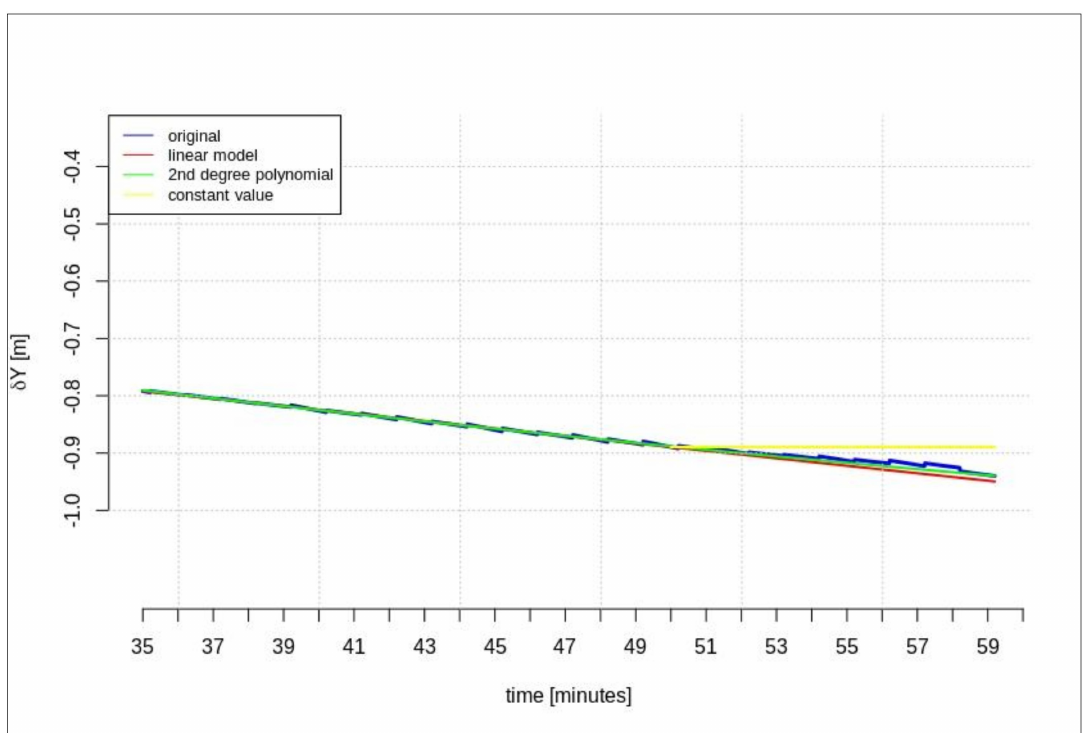
Figure 15. The results of the δ Y geocentric correction extrapolation (GPS G28) for a 15-min data-stream between each